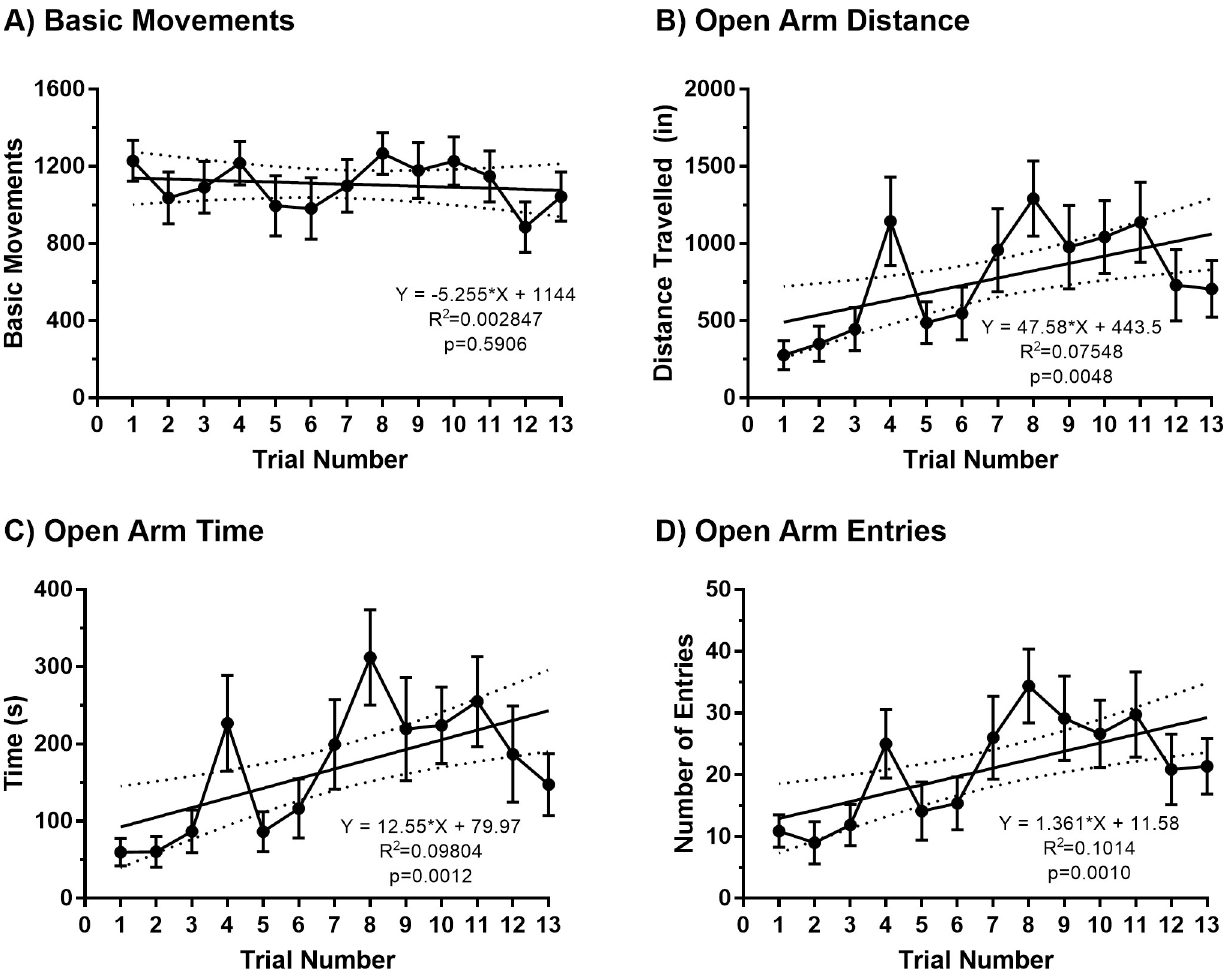
Fig 2. Linear trends for general performance and open arm measures across repeated EPM trials. Lines of best fit for basic movements (A), open arm distance (B), open arm time (C), and open arm entries (D) cross 13 repeated EPM trials (Experiment 1). Data are presented as mean and standard error (N = 8), with the equation and p-value for each analysis shown on the